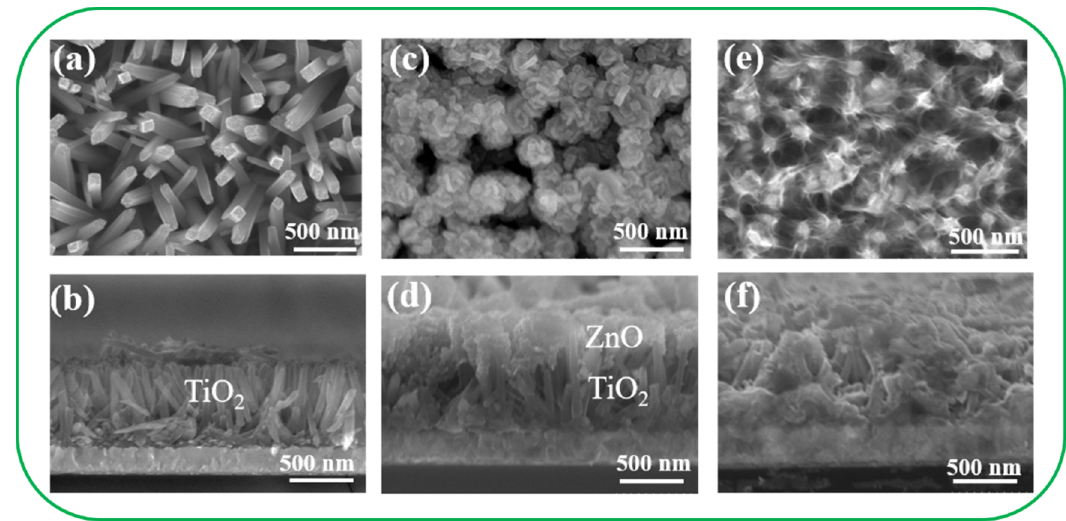
− ZnO − C; ( e , f ) TiO − ZnO − H. 2